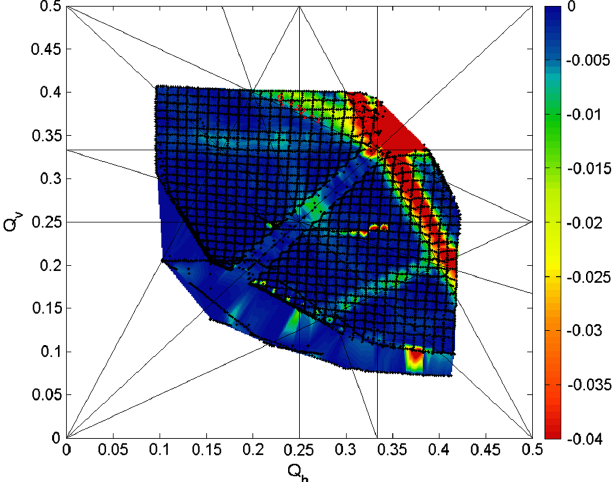
FIG. 34. Tune diagram resulting from the loss measurement at 2 GeV. The color scale indicates the derivative of the BCT signal, i.e., the red lines indicate the larger